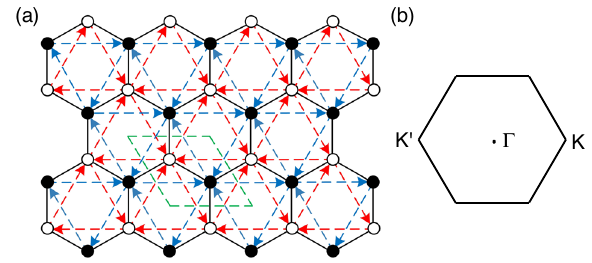
Fig. 1 Schematic and Brillouin zone (BZ) of the Haldane model. a Schematic of the Haldane model with a real nearest-neighbor (NN) hopping (black lines), a complex next-nearest-neighbor (NNN) hopping (red and blue arrows), and on-site staggering energies (white and black circles). The rhombus with green lines is the unit cell. b BZ of the Haldane model, where K and K ′ are the two